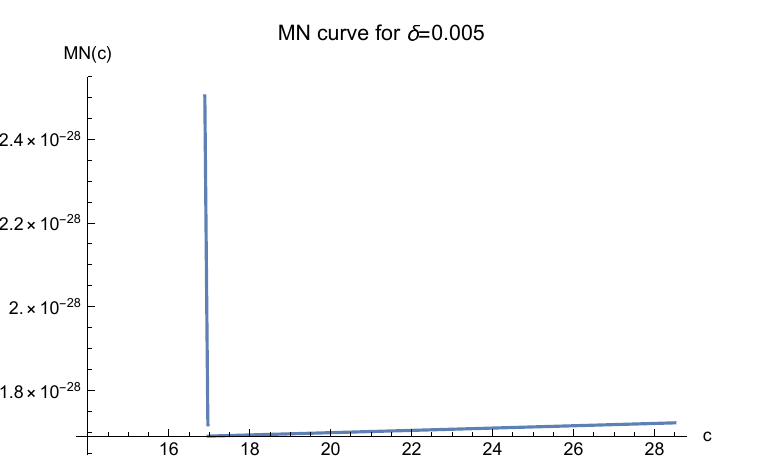
Figure 13. MN curve for δ = 0.01 where d = 2, β = 1, b 0 =